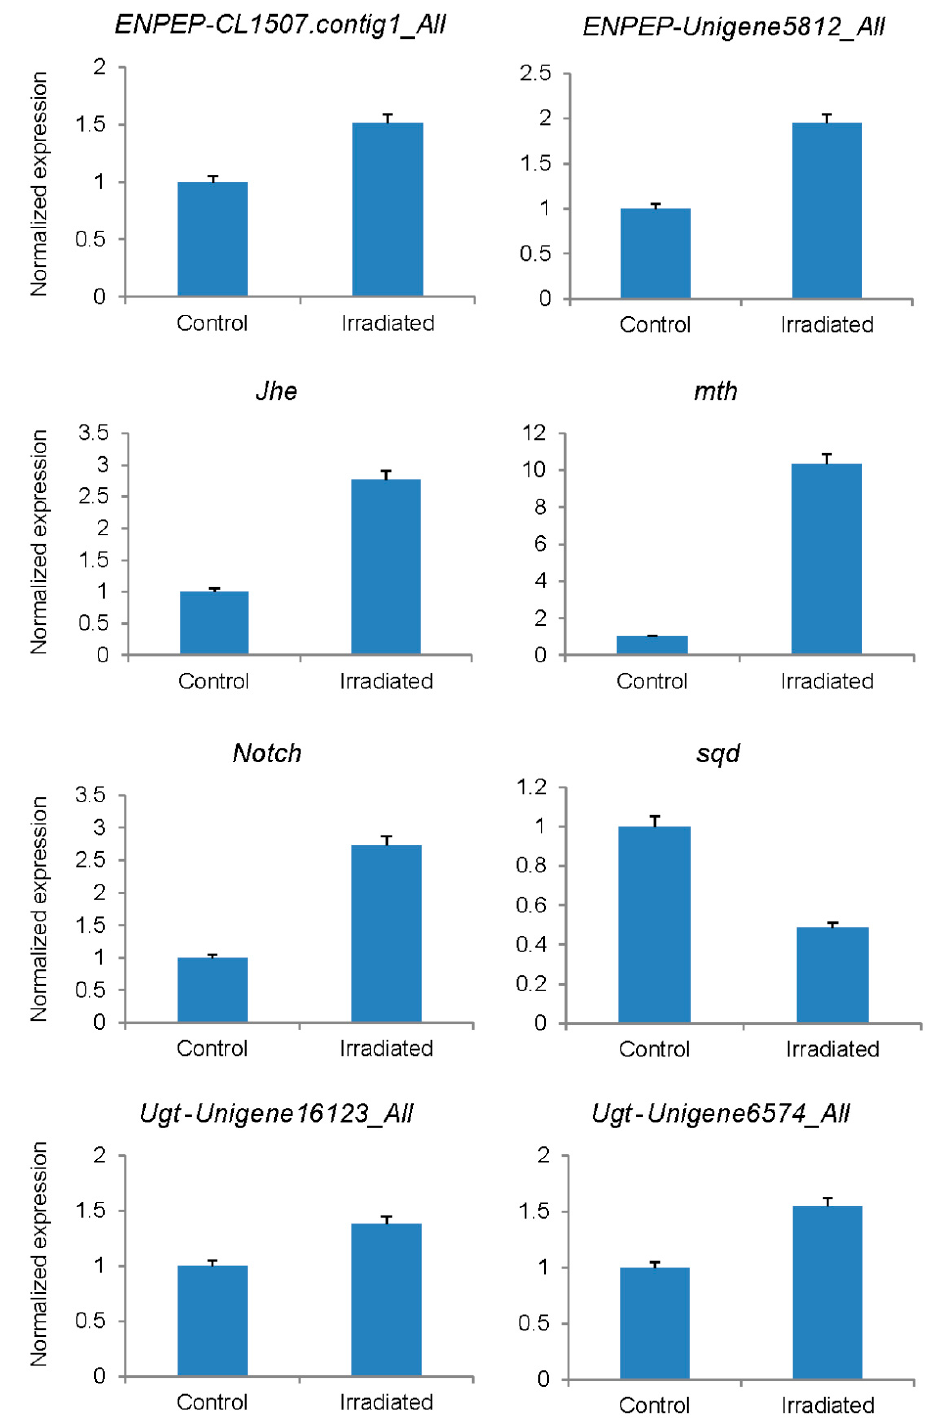
Figure 4. qRT-PCR confirmation of the differentially expressed genes between irradiated samples and controls.